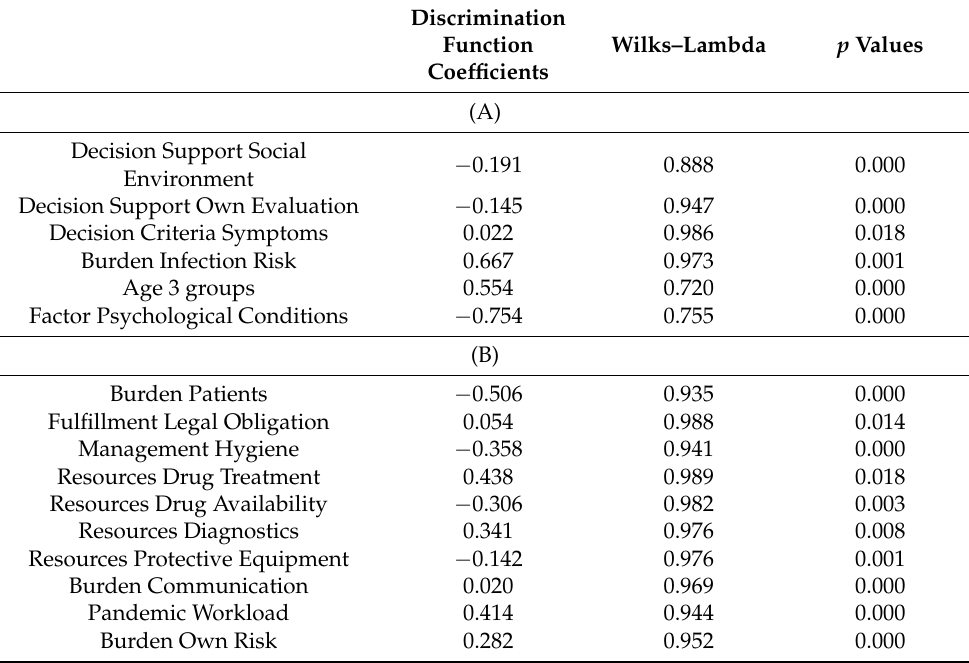
Table 1. Standardized canonical discrimination function coefficients for differentiation between (A) patients in oncology and psychiatry; and (B) nurses and physicians. All included items showed significant differences of the group means (Wilks–Lambda